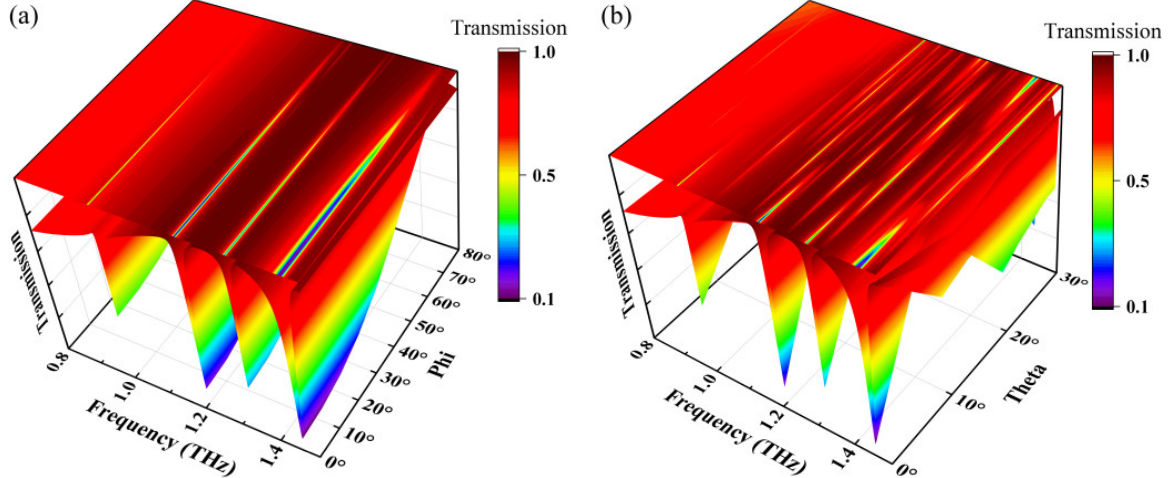
Figure 4. The transmission spectrum of the sensor as a function of ( a ) polarization angle and ( b ) angle of incidence.